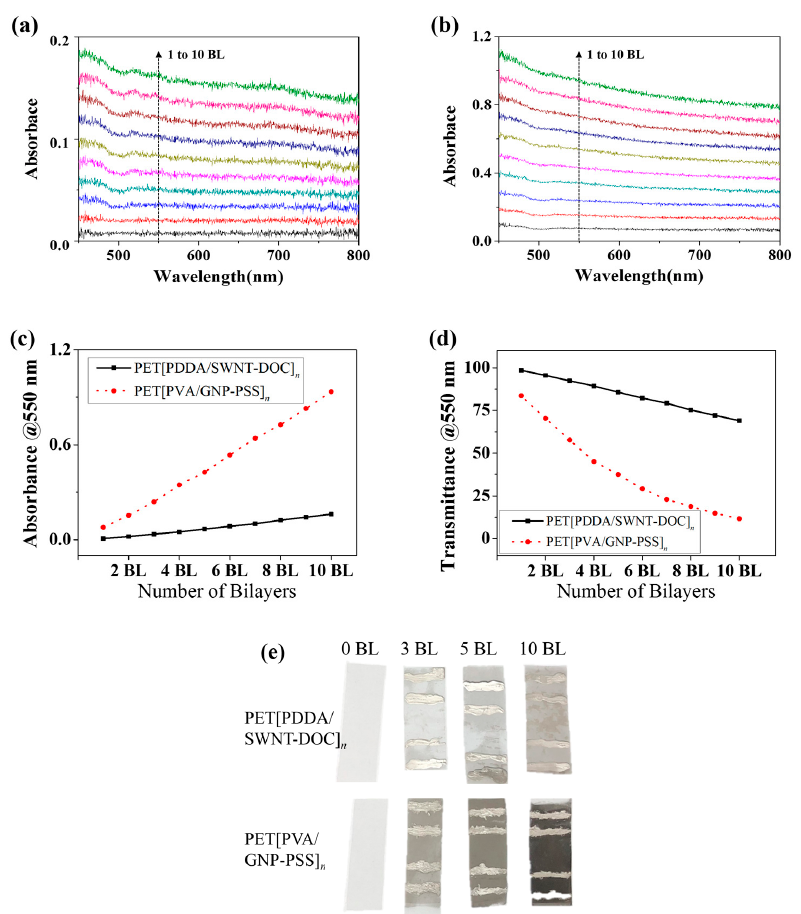
Figure 4. ( a ) Visible light absorbance spectra of PET[PDDA/SWNT-DOC] n ( n = 1–10) LbL thin films. ( b ) Visible light absorbance spectra of PET[PVA/GNP-PSS] n ( n = 1–10) LbL thin films. ( c ) Visible light absorbance of PET[PDDA/SWNT-DOC] n ( n = 1–10) (solid line) and PET[PVA/GNP-PSS] n ( n = 1–10) (dotted line) at 550 nm wavelength. ( d ) Visible light transmittance of PET[PDDA/SWNT-DOC] n ( n = 1–10) (solid line) and PET[PVA/GNP-PSS] n ( n = 1–10) (dotted line) at 550 nm wavelength. ( e ) Images of PET[PDDA/SWNT-DOC] n ( n = 3, 5, 10) and PET[PVA/GNP-PSS] n ( n = 3, 5, 10) with control (0 BL) samples. In the LbL samples above, the silver material on each sample surface is silver paste applied for four-point probe